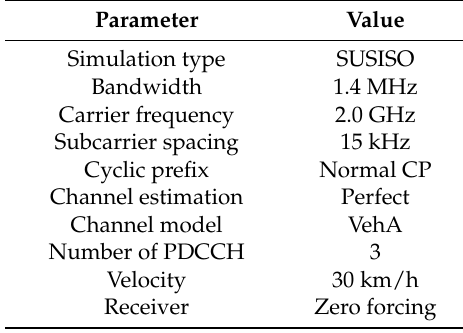
Table 1. Common simulation parameters for performance evaluation. SUSISO—single-user single-input